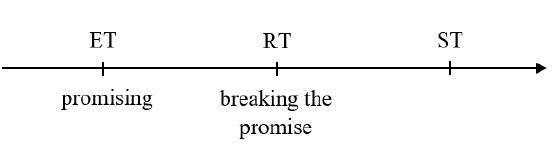
Figure 3. Reversed result